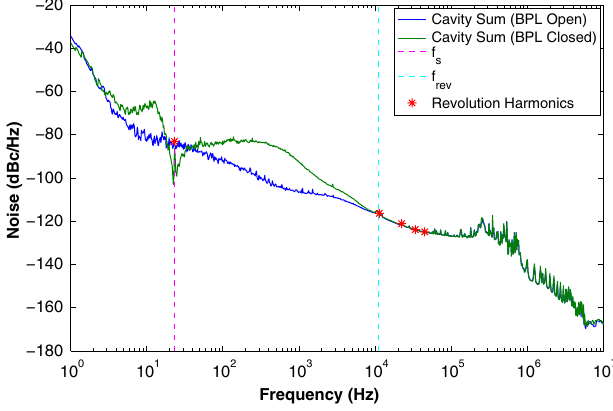
FIG. 4. Beam 2 cavity sum signal with BPL